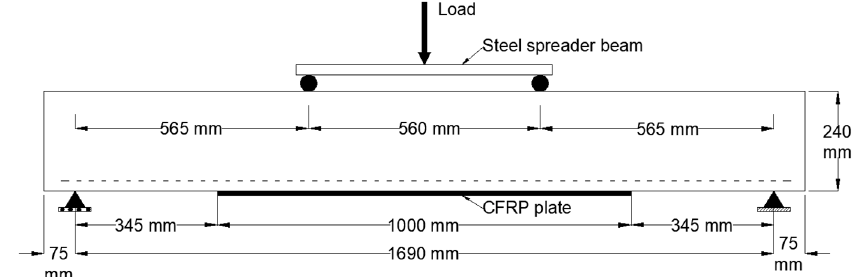
Figure 4. Test setup for S specimen as an example.